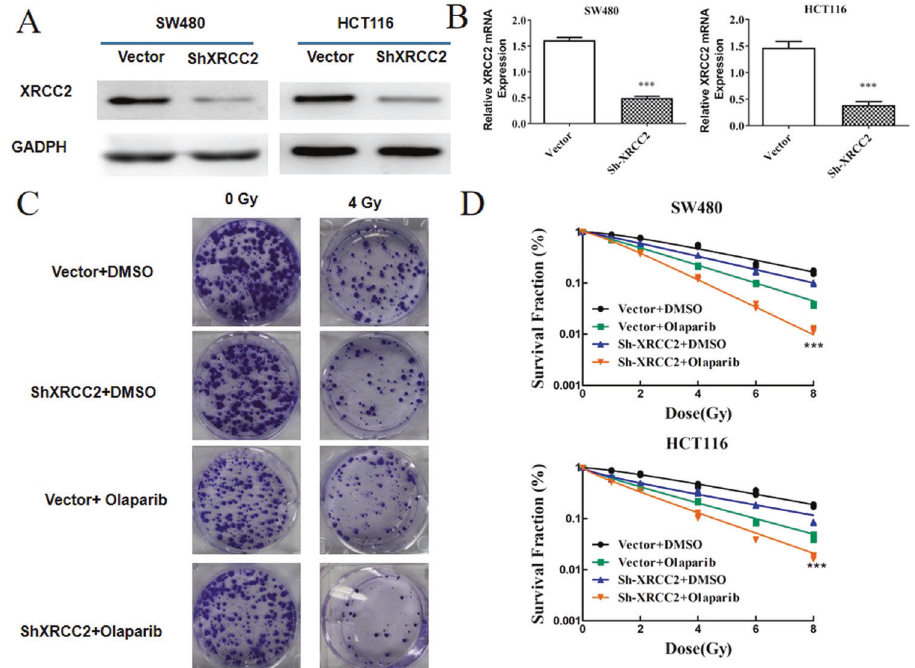
Fig. 2 Effect of olaparib on the radiosensitivity of XRCC2-de fi cient rectal cancer cells. A Western blotting of XRCC2 in SW480 and HCT116 cells with (shXRCC2) and without (vector) XRCC2 knockdown. B qRT-PCR of XRCC2 in SW480 and HCT116 cells with (shXRCC2) and without (vector) XRCC2 knockdown. *** P < 0.001. C Representative images of the clonogenic cell survival assays in the different treatment groups. D Effect of IR dose on survival of cells in different groups. Lines are from statistical fi ts to the mean values from three independent experiments to a linear-quadratic (multi-target/single-hit) model.